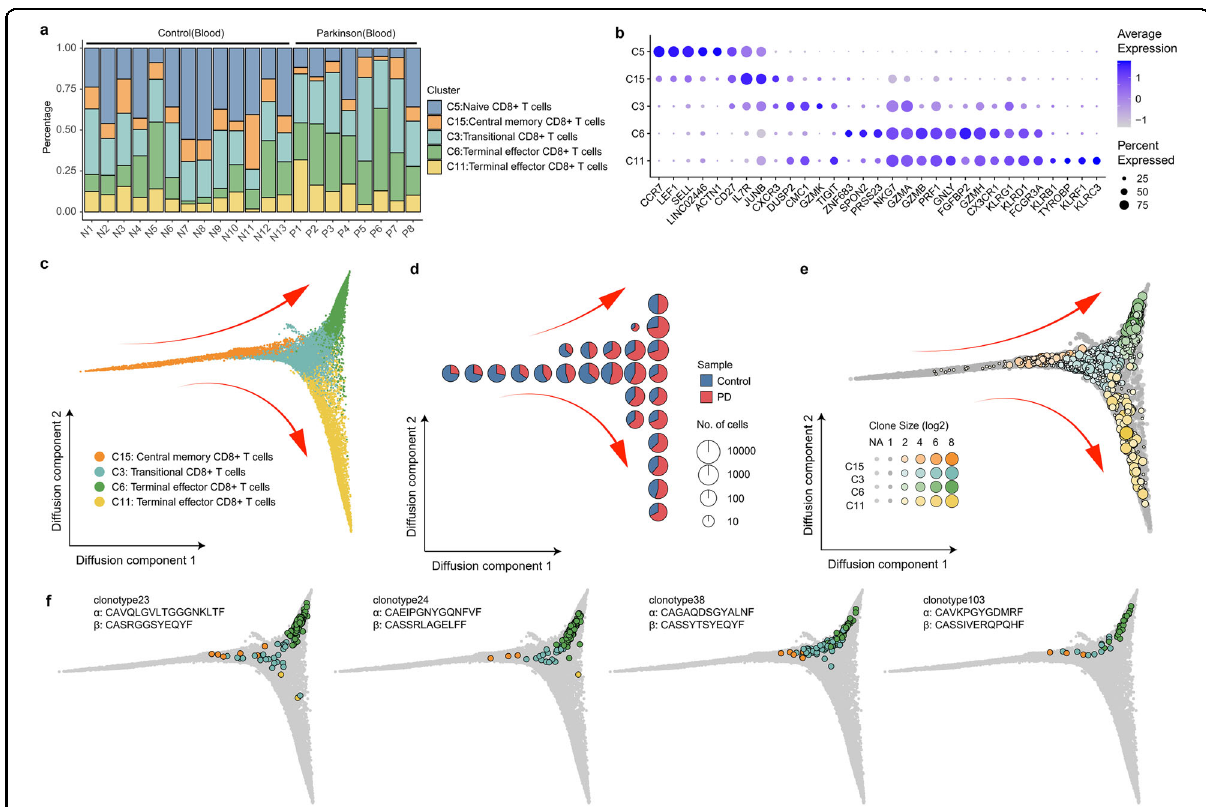
Fig. 3 Relationship among CD8 + T cell clusters based on both transcriptome and TCR data. a Percentage of CD8 + T cells in each sample shows reduction of naïve CD8 + T cells (C5 cluster) and expansion of terminal effector CD8 + T cells (C6 cluster) in the blood of PD patients. b Dot plot shows the expression of the Top 5 highly expressed genes in each cluster. The size of the dot corresponds to the percentage of cells expressing the gene in each cluster, and the color represents the average log normalized gene expression. c Pseudotime ordering of CD8 + T cells in a diffusion trajectory using the fi rst two diffusion components. Each dot represents a cell colored by different cell cluster. The main trajectories were indicated with arrows. d Cell sample composition in the diffusion trajectories. The diffusion trajectory in c was divided into 10 × 10 square grids according to the horizontal and vertical coordinates, and each pie chart re fl ects the sample composition of cells in each grid area. e Clonotypes distributed in the diffusion trajectories. Each dot represents a unique clonotype in each cluster. The size of the dot re fl ects the clone size in each cluster. Clonotypes with clone size >1 were colored by cluster. Nonclonal clonotypes are colored in gray. The coordinates of each clonotype were calculated by the average coordinates of the cells in the clonotype. f Examples of clonally expanded CD8 + T cells in different cell types. Cells from 4 clonotypes (clonotype23, clonotype24, clonotype38 and clonotype103) were highlighted in the diffusion trajectories. Each dot represents a cell colored based on its